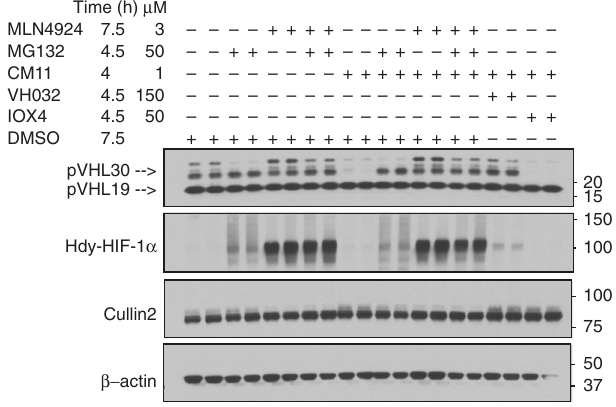
Fig. 6 CM11 activity is CRL2 VHL and proteasome-dependent. HeLa cells treated with CM11 in the absence or presence of proteasome inhibitor MG132, neddylation inhibitor MLN4924, VHL inhibitor VH032 or PHD2 inhibitor IOX4 as negative control. The data demonstrated here is representative of one biological with Elongin B and Elongin C) 60 the stoichiometry of binding ( n value) was found to be 0.6, compared to n = 1 with VH032 (Fig. 7a, Table 1). This result is consistent with CM11 binding to VHL in a 1:2 molar ratio, in contrast to VH032 that binds to VHL in a 1:1 ratio 18 . Notably, the K d value measured for CM11 was 11 nM (Table 1). Closer examination of the titration curve revealed that only one point features during the in fl ection of the curve.